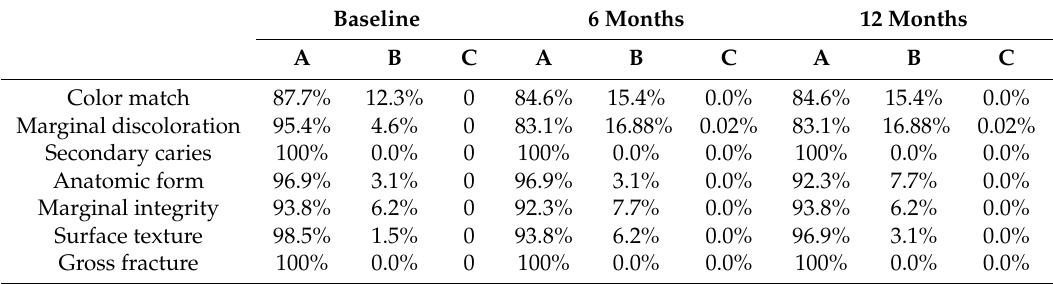
Table 2. Quality assessment of the restoration at baseline, 6 months, and 12 months follow-up.